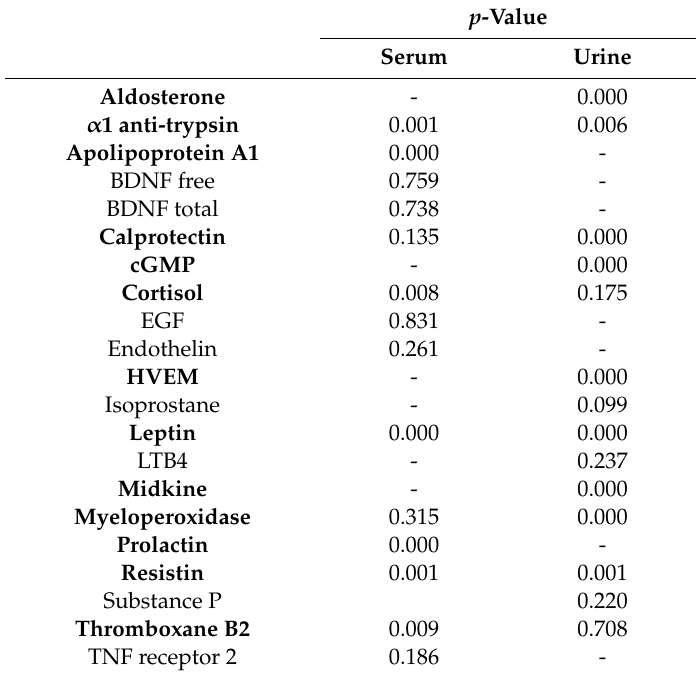
Table 4. Di ff erences in serum and urine biomarker concentrations between men and women with MDD.